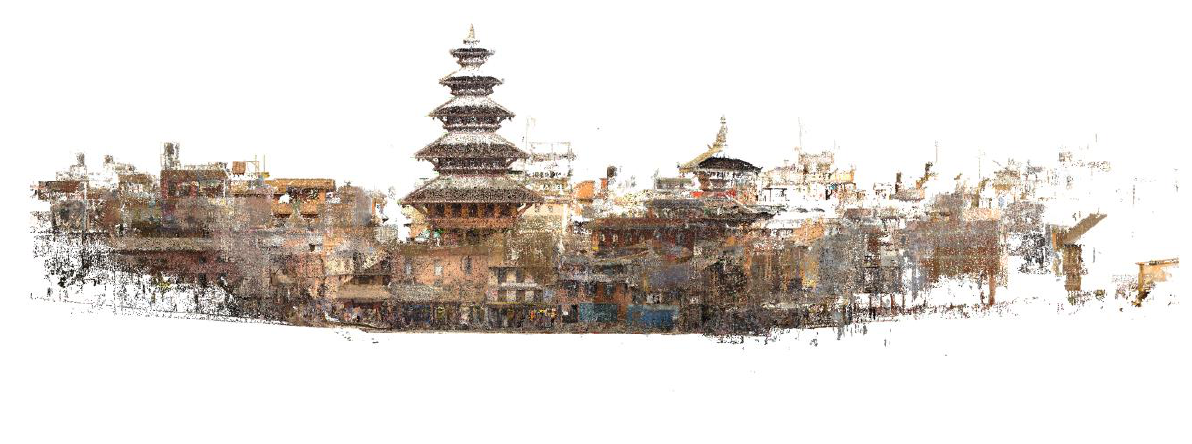
Figure 1. Taumadhi Square Point Cloud, Bhaktapur